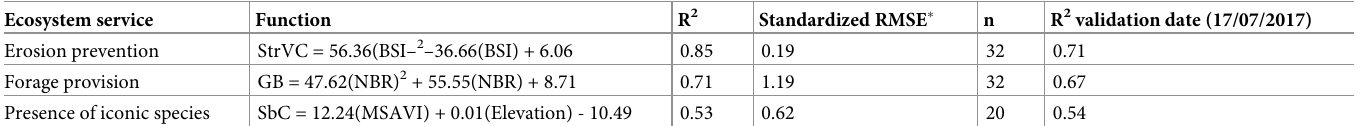
Table 5. Selected ecosystem service models based on indices derived from calibration between field measurements with Landsat 8 (14/05/2017) data and terrain variables. Ecosystem